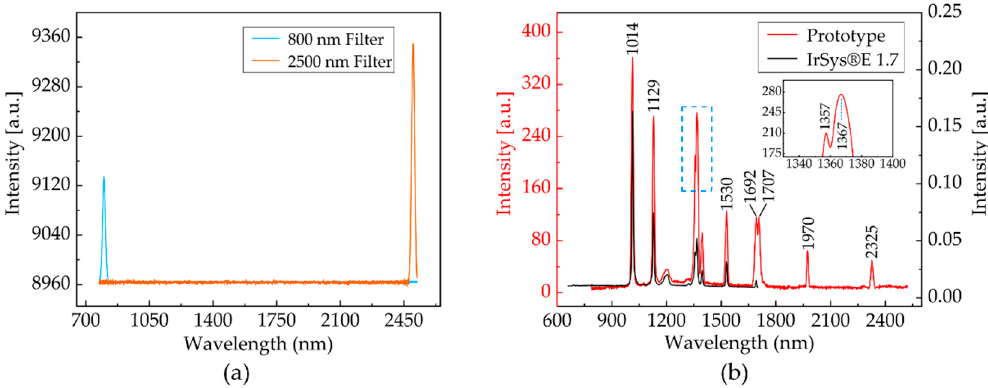
Figure 6. ( a ) Wavelength range of the prototype; and, ( b ) An array-detection-based near-infrared spectrometer and the prototype were tested using a mercury lamp experiment and the illustration indicates the highest resolution of the prototype.